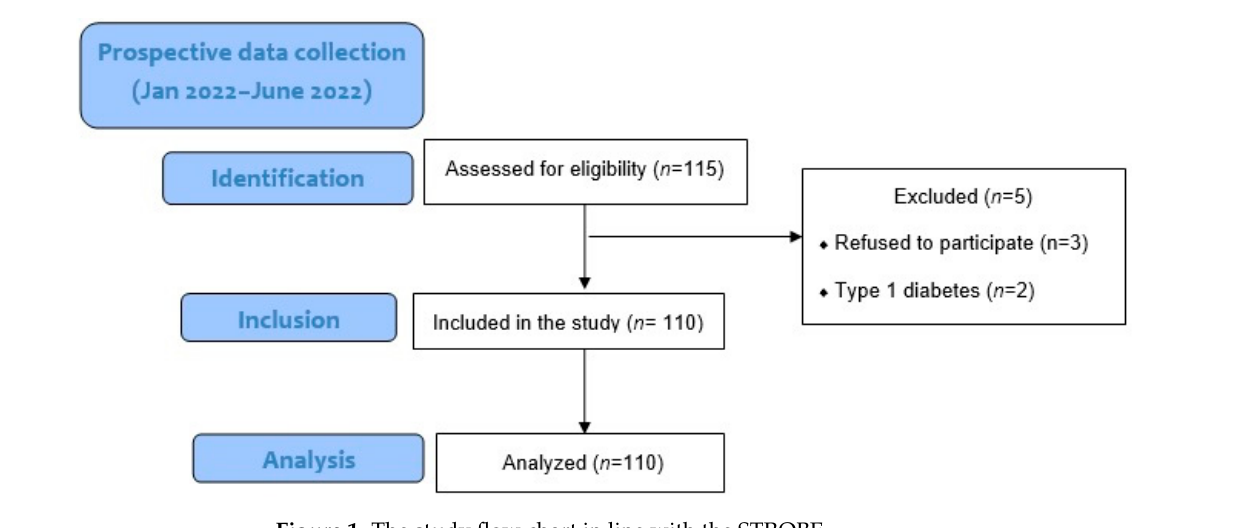
Figure 1. The study flow chart in line with the STROBE. Table 1. Demographic and clinical data.